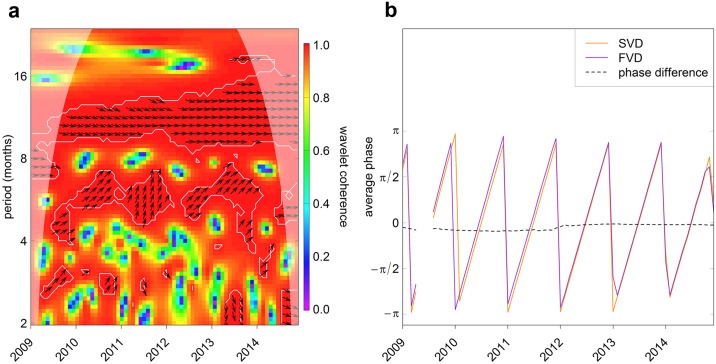
Results of wavelet analysis.a) Wavelet coherence between the two time series. Colour code from purple (low values) to red (high values). The arrows indicate synchrony of the two time series: arrows pointing to the right means the oscillations are synchronised. Arrows are only plotted within white contour lines that indicate significance. The shaded area near the edges in the graphs is the cone of influence, and indicates the range of the graph where the results are not reliable because of edge effects. b) Phases of the oscillations of the two time series (SVD—STEAM visitor days—in orange and FVD—Flickr visitor days—in purple) computed in the 8–16 periodic band where there is significant correlation. The dotted line is the phase difference.